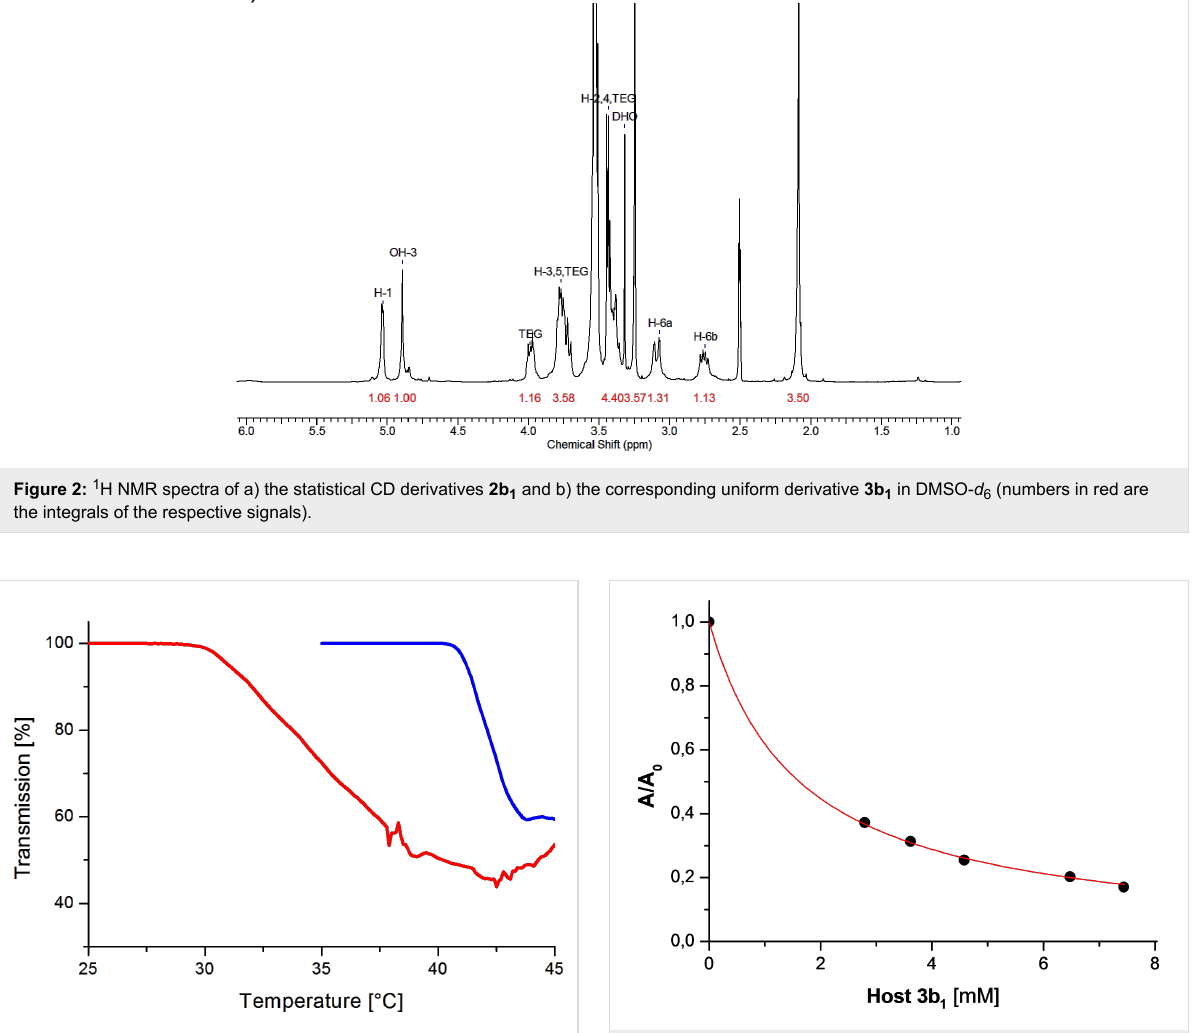
Figure 3: Transmission ( λ = 670 nm) of aqueous solutions (1.0 wt %) of 2b 1 (red) and 3b 1 (blue).